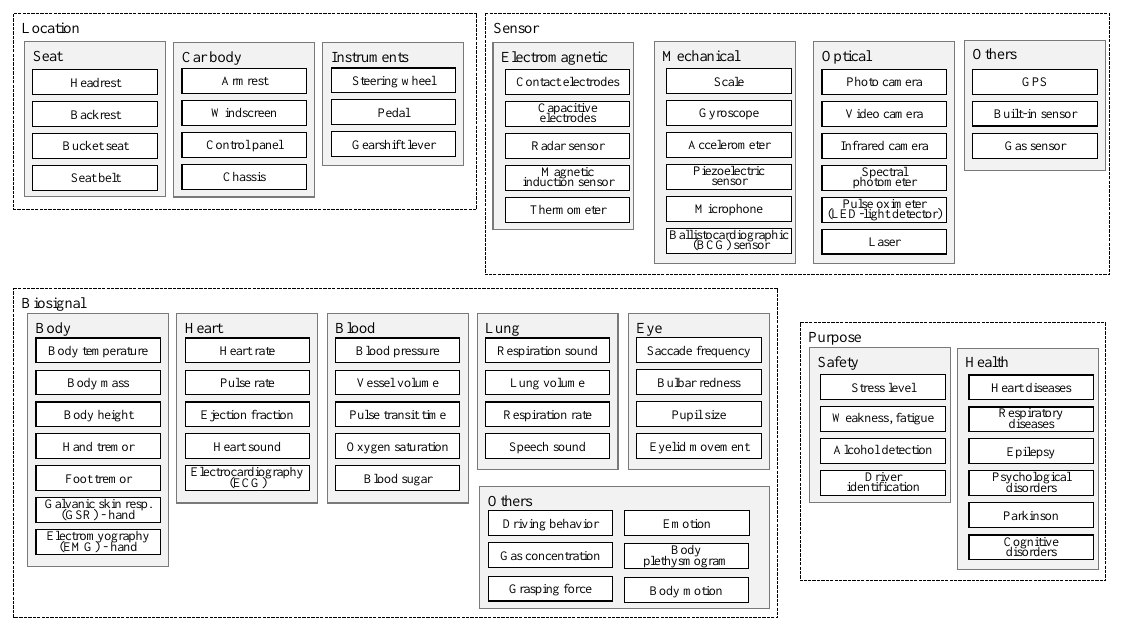
Figure 1. Terminology of unobtrusive in-vehicle health